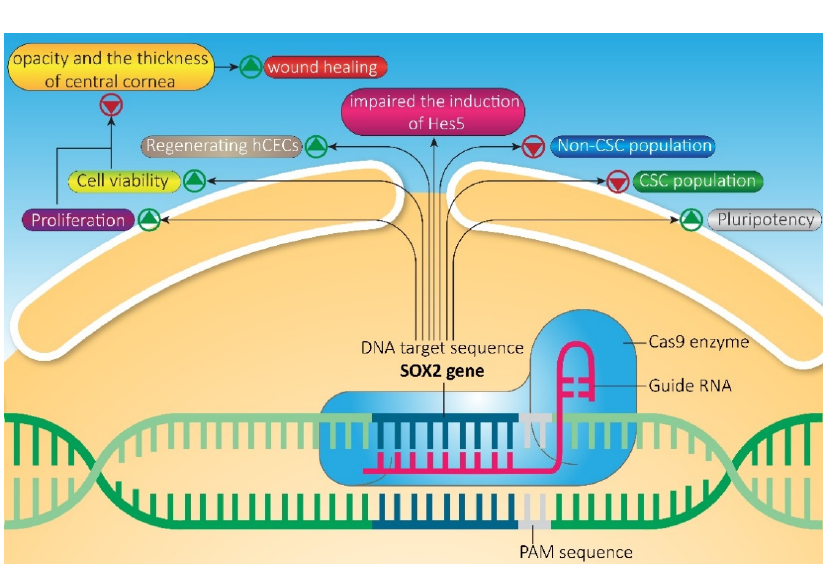
Figure 6. Applications of the CRISPR system to edit SOX2 . Editing SOX2 by CRISPR-Cas affects cell viability, proliferation, pluripotency, and tissue regeneration. Table 1. CRISPR targeting SOX2 .